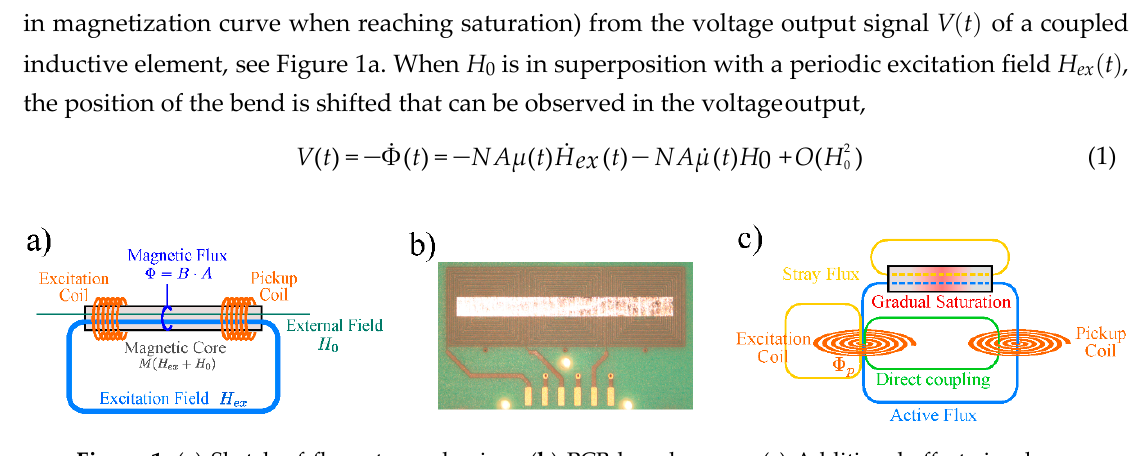
Figure 1. ( a ) Sketch of fluxgate mechanism, ( b ) PCB based sensor, ( c ) Additional effects in planar